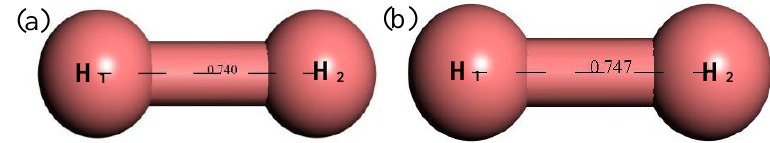
Figure 14. Molecular model of H 2 molecule. ( a ) Initial model; ( b ) Optimized model. The unit of the angle in the image is (°), and the unit of the bond length is angstrom (Å).